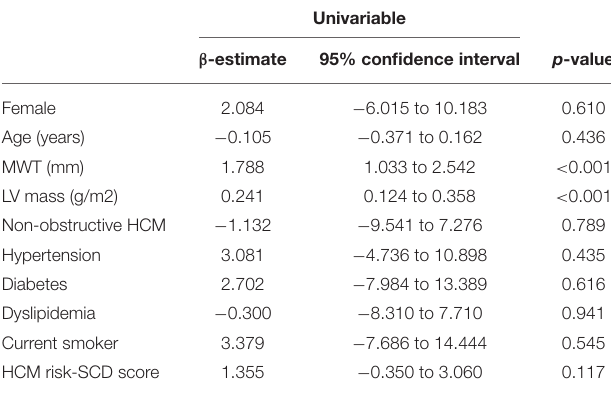
TABLE 3 | Univariable linear regression for factors related to